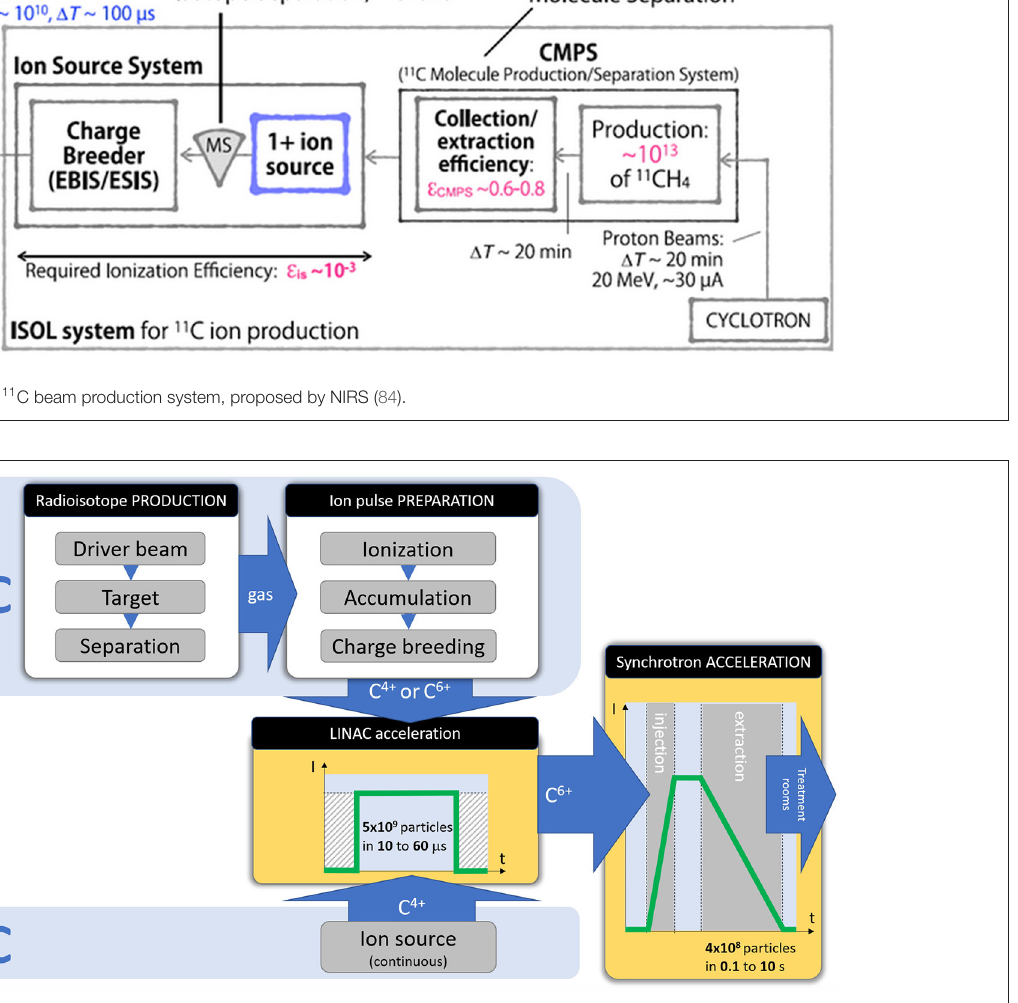
FIGURE 2 | Required stages and beam parameters for a therapy accelerator, and the differences between a 12 C and 11 C